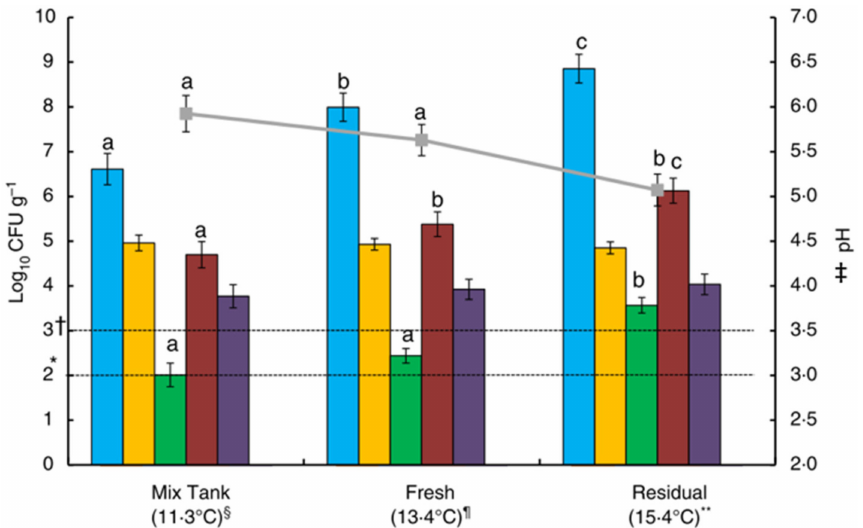
Figure 2. Mean ( ± SEM) counts of (blue) lactic acid bacteria; (orange) Enterobacteriaceae ; (green) Escherichia coli ; (brown) yeast and (purple) mould; and (grey line) feed pH ‡ in liquid feed sam- ples from the mixing tank, fresh feed from troughs and residual feed from troughs on eight Irish commercial finisher pig units. * Detection limit for lactic acid bacteria, Enterobacteriaceae and E. coli (2 log 10 CFU/g). † Detection limit for yeast and mould (3 log 10 CFU/g). ‡ Sample pH is displayed on the secondary y -axis. § Mix Tank sample temperature = mean of data from eight samples. ¶ Fresh sample temperature = mean of data from 24 samples. ** Residual sample temperature = mean of data from 21 samples. a,b,c Within each bar colour and the line representing pH, bars and data points, respectively, that do not share a common letter are significantly different ( p < 0.05). Adapted from O’Meara et al.